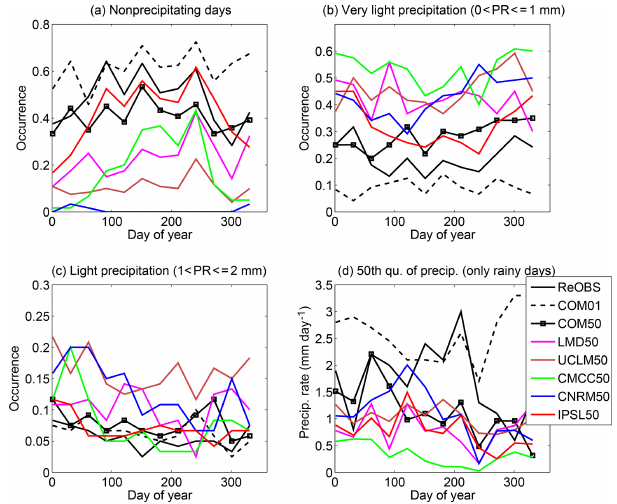
Figure 2. Occurrence for 30-day periods from January to December over the years 2004–2007 of (a) nonprecipitating days; (b) precip- itation rates between 0 and 1mmday − 1 ; (c) precipitation rates be- tween 1 and 2mmday − 1 . (d) Value of the 50th quantile of precip- itation (excluding nonprecipitating days). Each color corresponds to a different model at 50km resolution regridded to the LMD grid (see legend for details). Black line is for observations at SIRTA su- persite (ReOBS). Dashed black line is for COMEPHORE product at 1km × 1km resolution at the closest grid point of SIRTA (COM01) and black line with squares is for COMEPHORE averaged over a square of 50km × 50km around SIRTA